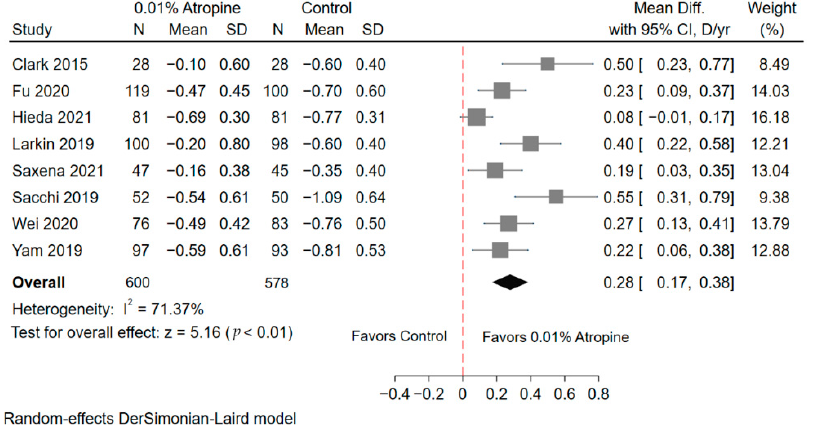
Figure 1. Forest plot of standardized equivalent refraction between the 0.01% atropine and control groups. SD, standard deviation; CI, confidence interval; D, diopter; yr, year. Table 2. Subgroup analyses of efficacy outcomes in standardized equivalent refraction. Standardized Equivalent Refraction (SER)